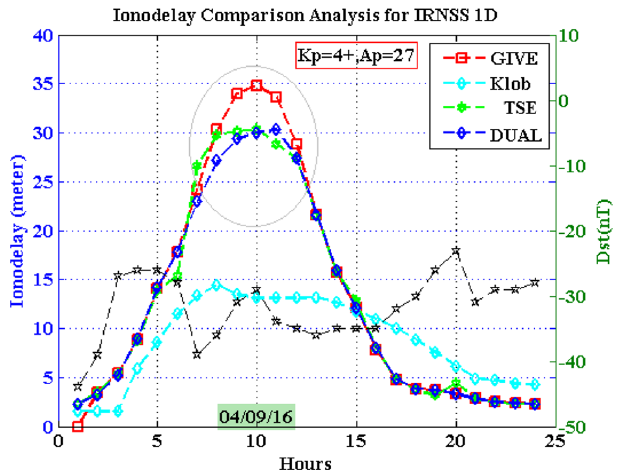
Fig. 14. Ionodelay estimation comparison for NavIC/IRNSS 1D